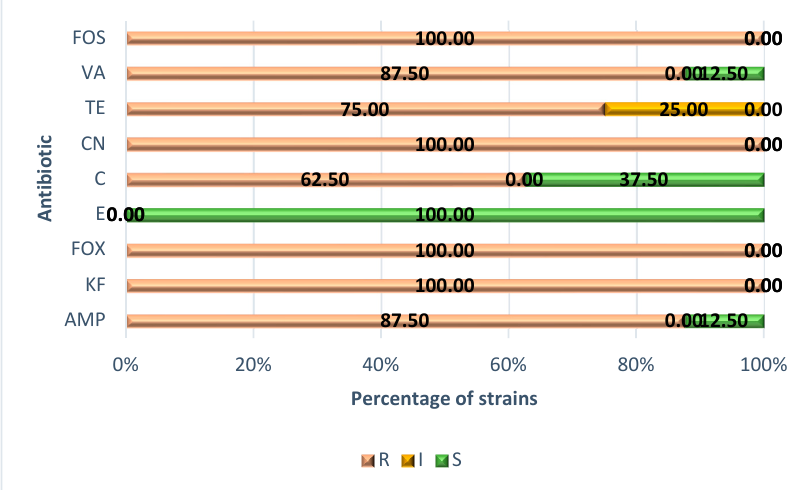
Figure 1. Percentage of strains of Listeria monocytogenes resistant (R), intermediate (I, with reduced susceptibility) or susceptible (S) to each of the nine antibiotics tested. AMP—ampicillin; KF—cephalothin; FOX—cefoxitin; E—erythromycin; C—chloramphenicol; CN—gentamicin; TE—tetracycline; VA—vancomycin; FOS—fosfomycin. LM— Listeria monocytogenes . American Type Culture Collection (ATCC) strains comprised ATCC 19111 (serotype 1/2a), ATCC 19112 (serotype 1/2c), ATCC 19114 (serotype 4a), ATCC 19117 (serotype 4d), and ATCC 13932 (serotype 4b). Those from the Spanish Type Culture Collection (STCC) comprised STCC 936 (serotype 1/2b), STCC 937 (serotype 3b), and STCC 938 (serotype 3c).